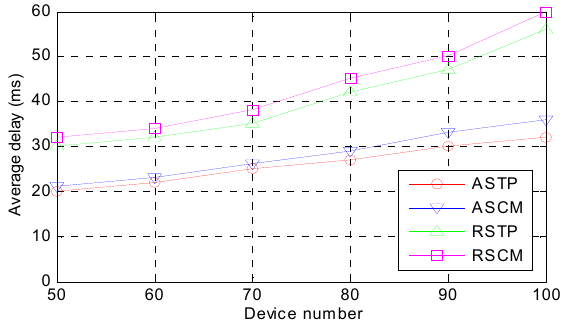
Figure 5. Comparison of the average time delay.